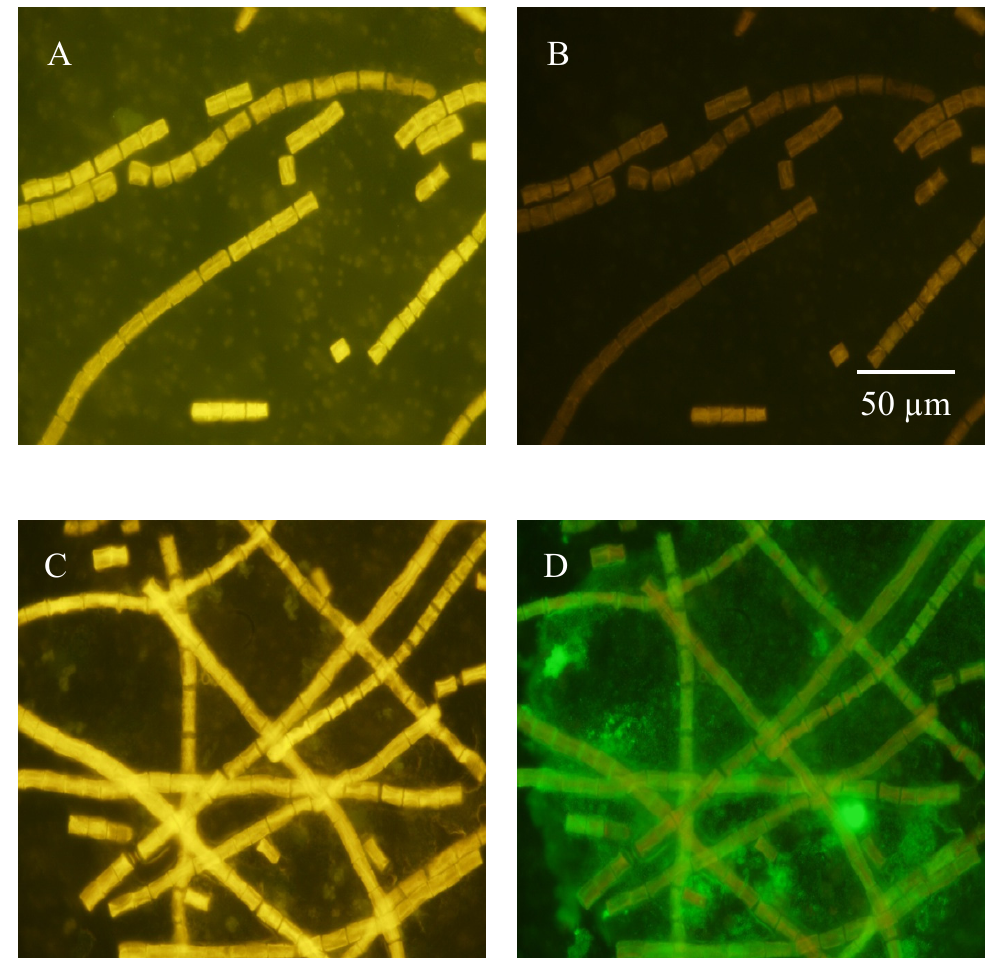
Figure 2. Immunofluorescence detection of IdiA accumulation in T. erythraeum cells. Binding of the IdiA antibody to cellular structures was visualized by subsequent incubation with the Qdot 525 anti-rabbit IgG antibody. Autofluorescent trichomes from iron replete cultures prior to blue light photobleaching treatment (A). The same field after photobleaching with minimal Qdot 525 signal (B). Autofluorescent trichomes from iron depleted cultures prior to photobleaching treatment (C). The same field after photobleaching exhibiting strong Qdot 525 labeling of the trichomes and cellular debris (D). All images captured at 1000X